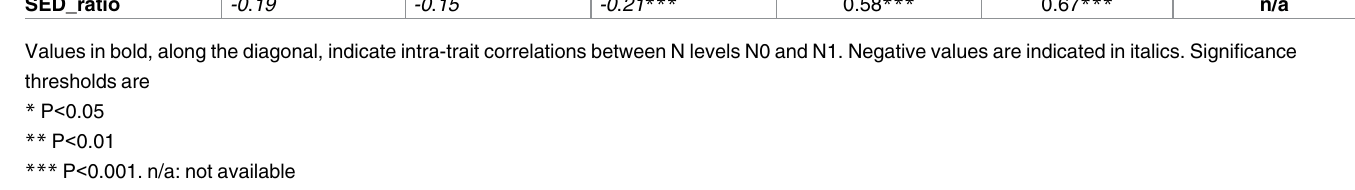
Values in bold, along the diagonal, indicate intra-trait correlations between N levels N0 and N1. Negative values are indicated in italics.